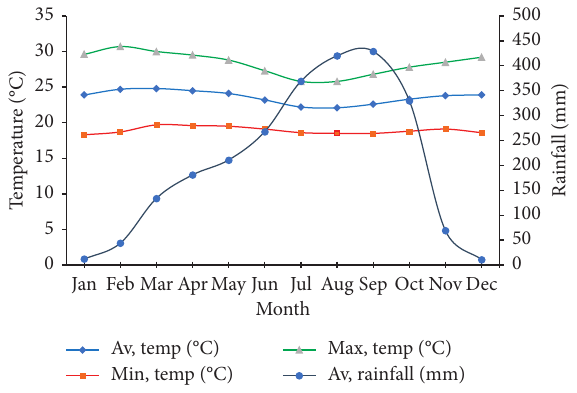
Figure 2: Climatic diagram of study